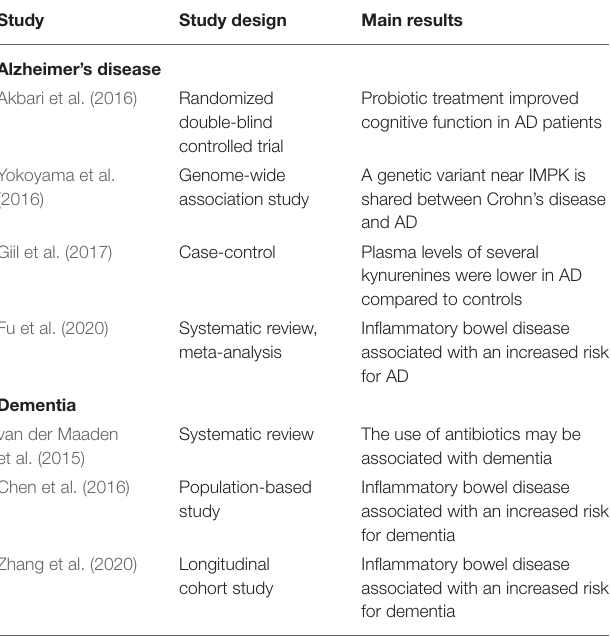
TABLE 5 | Studies investigating the association between the gut microbiome, dementia and